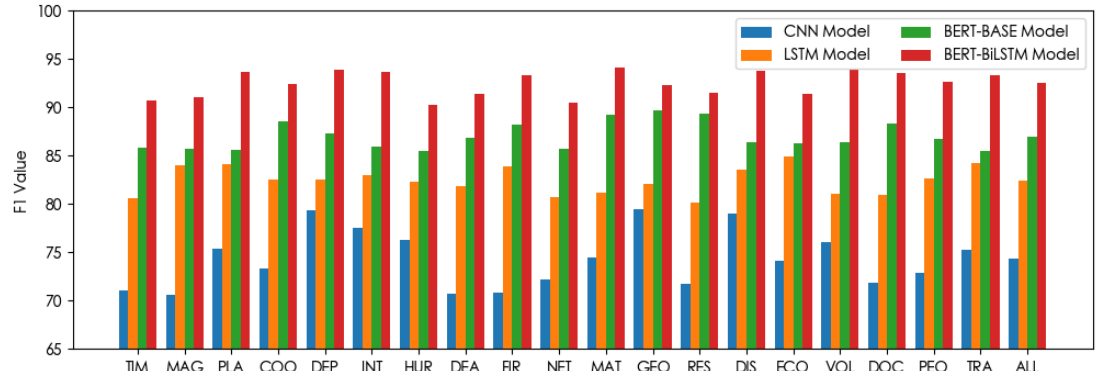
Figure 7. Experimental results for F 1 values.